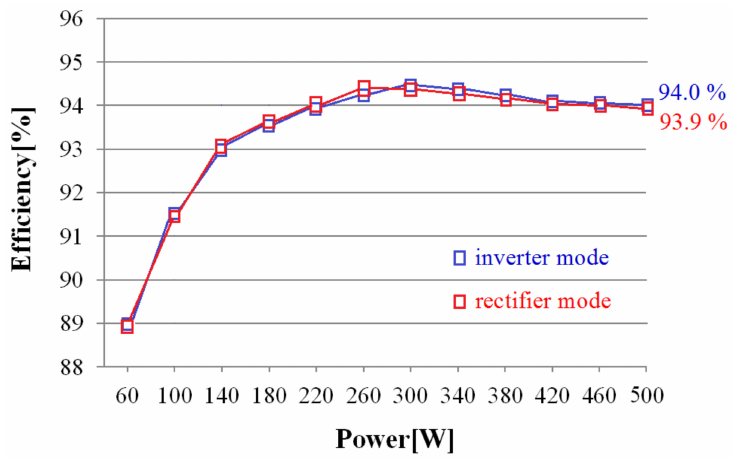
Figure 7. Measured power e ffi ciency